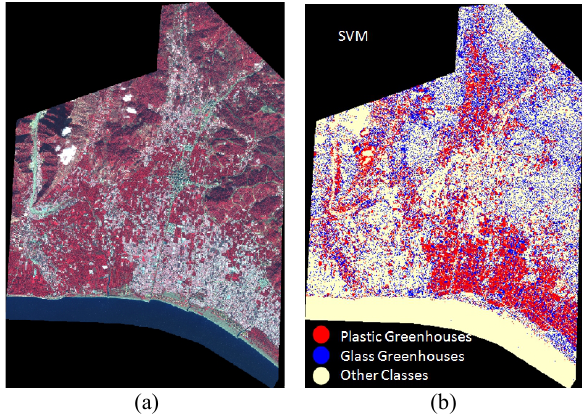
Figure 2. The infrared color composite of Kumluca WorldView-2 satellite imagery (a) and the SVM classification result (b).